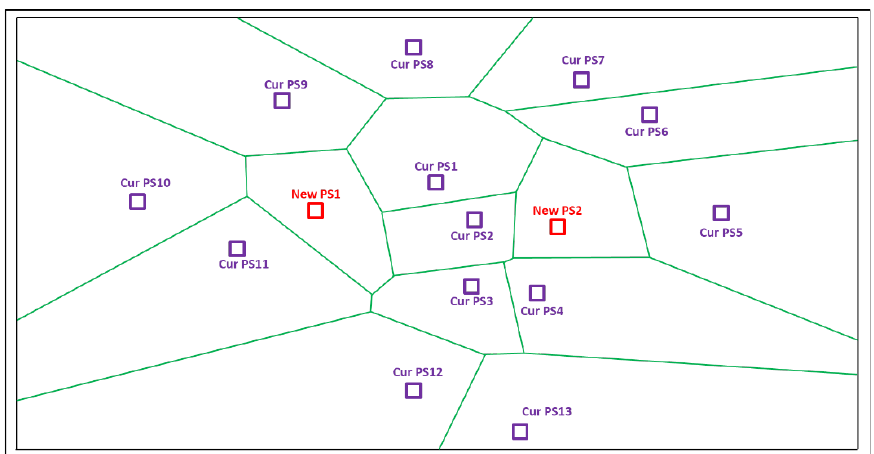
Figure 14. Example of siting two new PSs among several others already in place. New PSs are in red while existing ones are in purple.